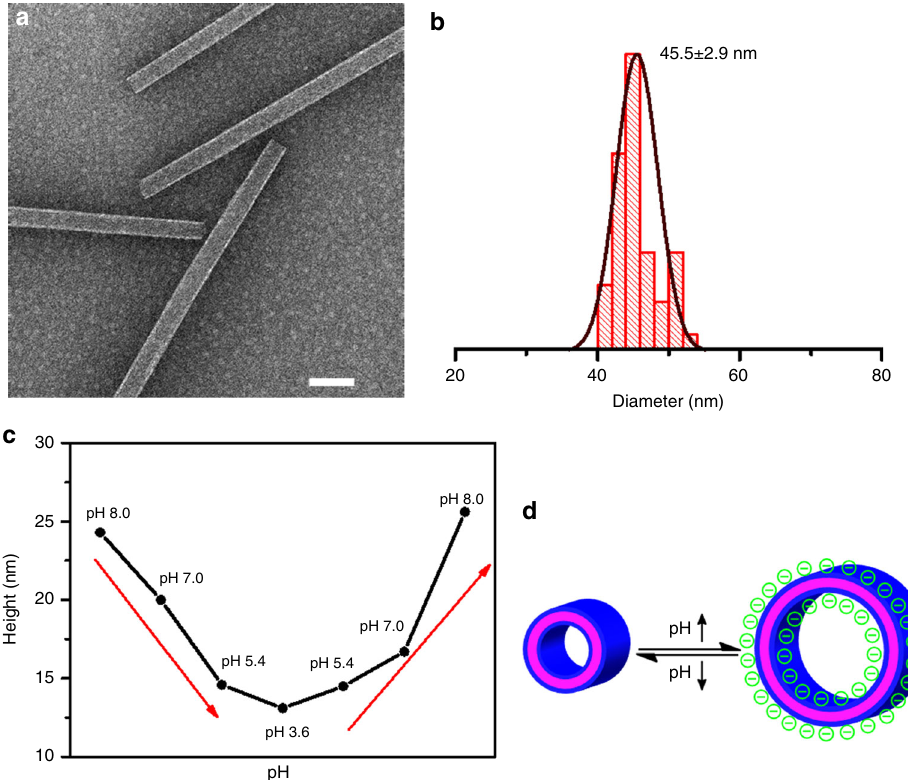
Fig. 4 pH-responsive structural dynamics of APO2-PNTs. a TEM image of APO2-PNTs dispersed in pH 11.94 aqueous solution for 6 h (scale bar, 100 nm). b Statistical diameter distribution of pH-triggered APO2-PNTs measured from the TEM results. The number above histogram is the average tubular diameter; 50 nanotubes were analyzed for each size distribution. c The AFM height change of one fi xed APO2-PNT in response to the solution pH variation. In the experiments, PNTs have been incubated with various aqueous solutions with different pH values (8.0, 7.0, 5.4, 3.6). The whole process was monitored in real time using in situ AFM. d A scheme showing the proposed mechanism of pH-triggered PNT height changes as a result